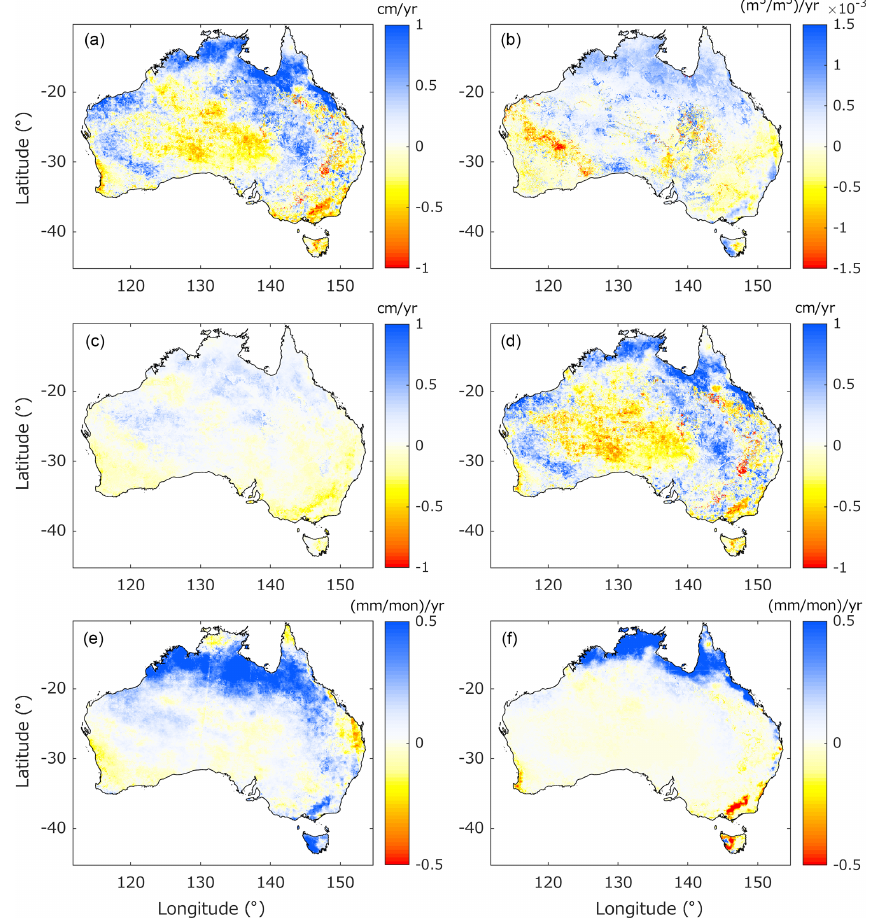
Figure 7. Long-term trends computed from CABLE 0.05 ◦ between January 1981 and December 2012, showing the (a) terrestrial wa- ter storage (TWS), (b) surface (volumetric) soil moisture (SSM), (c) total soil moisture storage (SMS), (d) groundwater storage (GWS), (e) evapotranspiration (ET), and (f) total